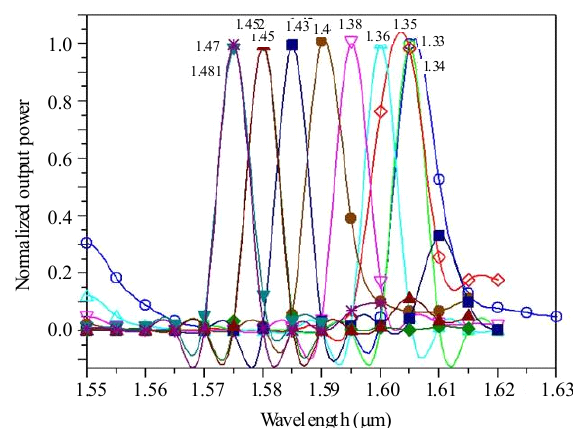
Fig. 4 Normalized transmission spectrum of the proposed biosensor at normal condition.